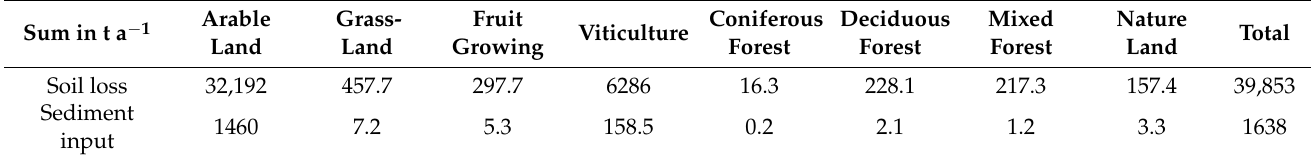
Table 6. Soil loss and sediment input in t per year in the catchment of the Kraichbach